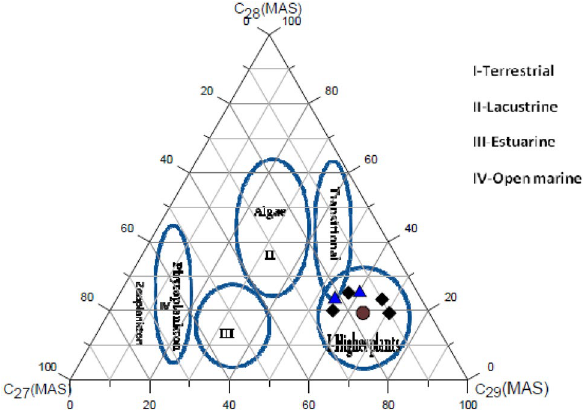
Fig. 16 Ternary diagram of the distribution of C 27 , C 28 , C 29 monoaro- matic steroid in Maiganga coal, shale and coaly shale, Gombe Forma- tion. The coals are plotted in terrigenous portion due to predominance of C 29 MAS. After Moldowan et al.